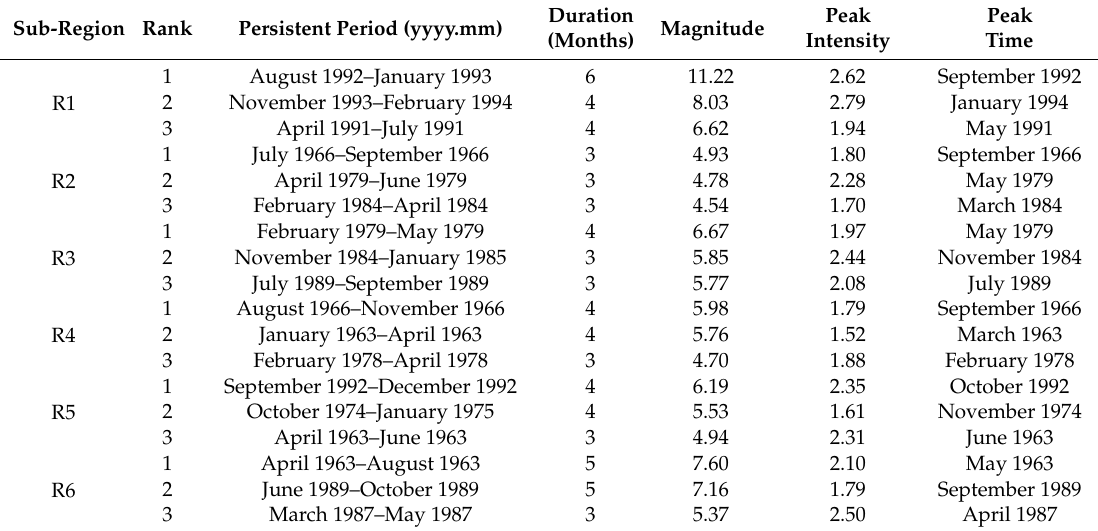
Table 3. Drought characteristics of the three most severe drought events ranked by magnitude in the six sub-regions from 1961 to